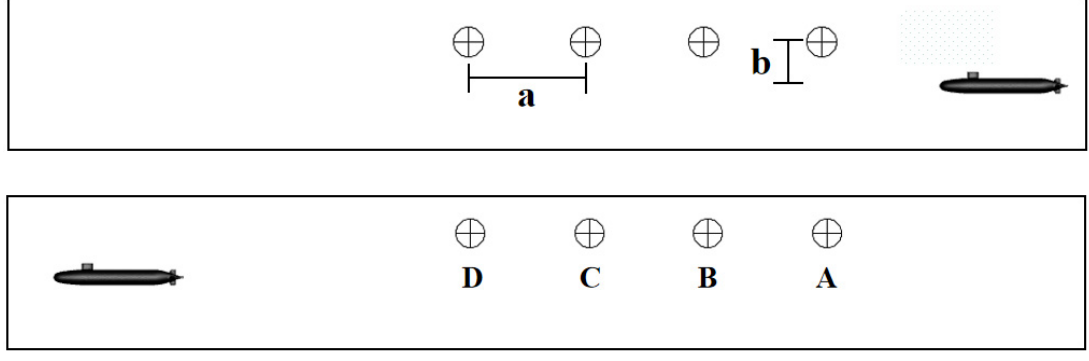
Figure 8. Setting the submarine wake magnetic field monitoring points. ( a is the distance between the two monitoring points; b is the vertical distance from the monitoring point to the submarine; A, B, C and D are four wake magnetic field monitoring points).